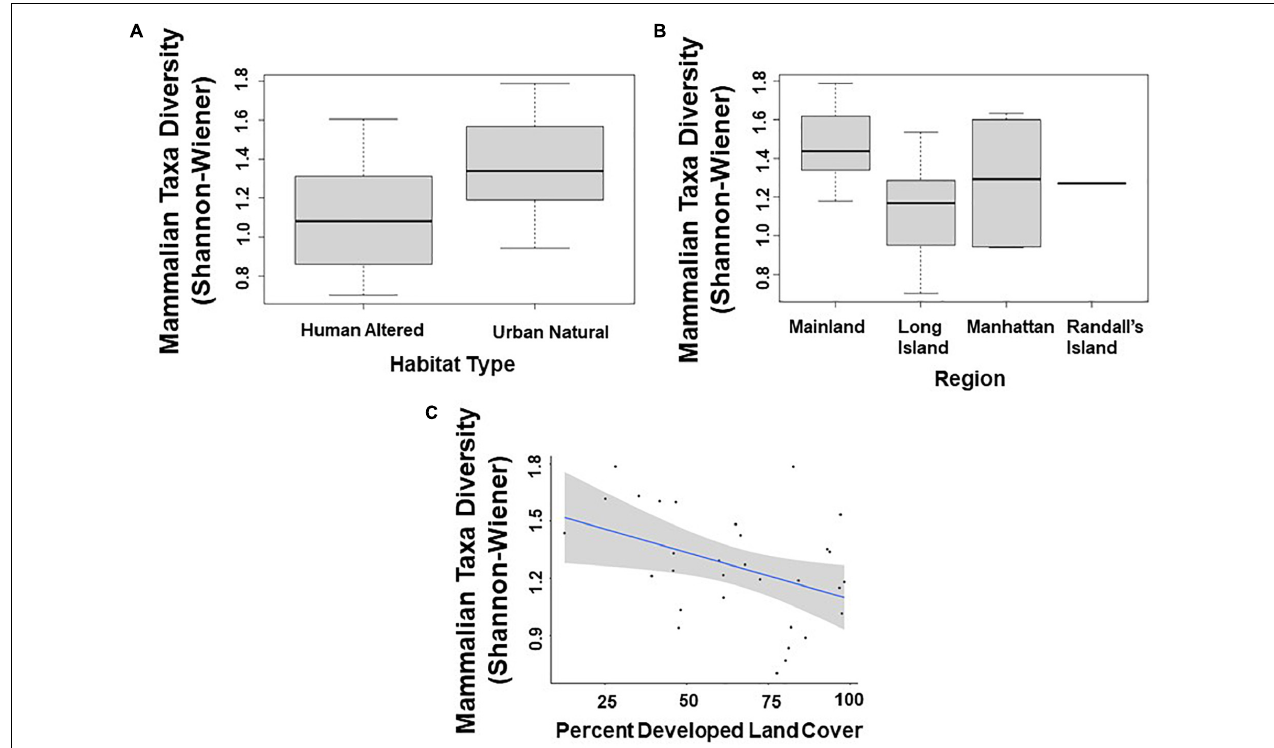
FIGURE 3 | Patterns among mammalian taxa diversity (Shannon–Wiener index) and (A) type of habitat; (B) region; and (C) percent developed land cover (1,000 m scale) across the 31 study sites. Points and whiskers on the plot represent the mean and standard error.